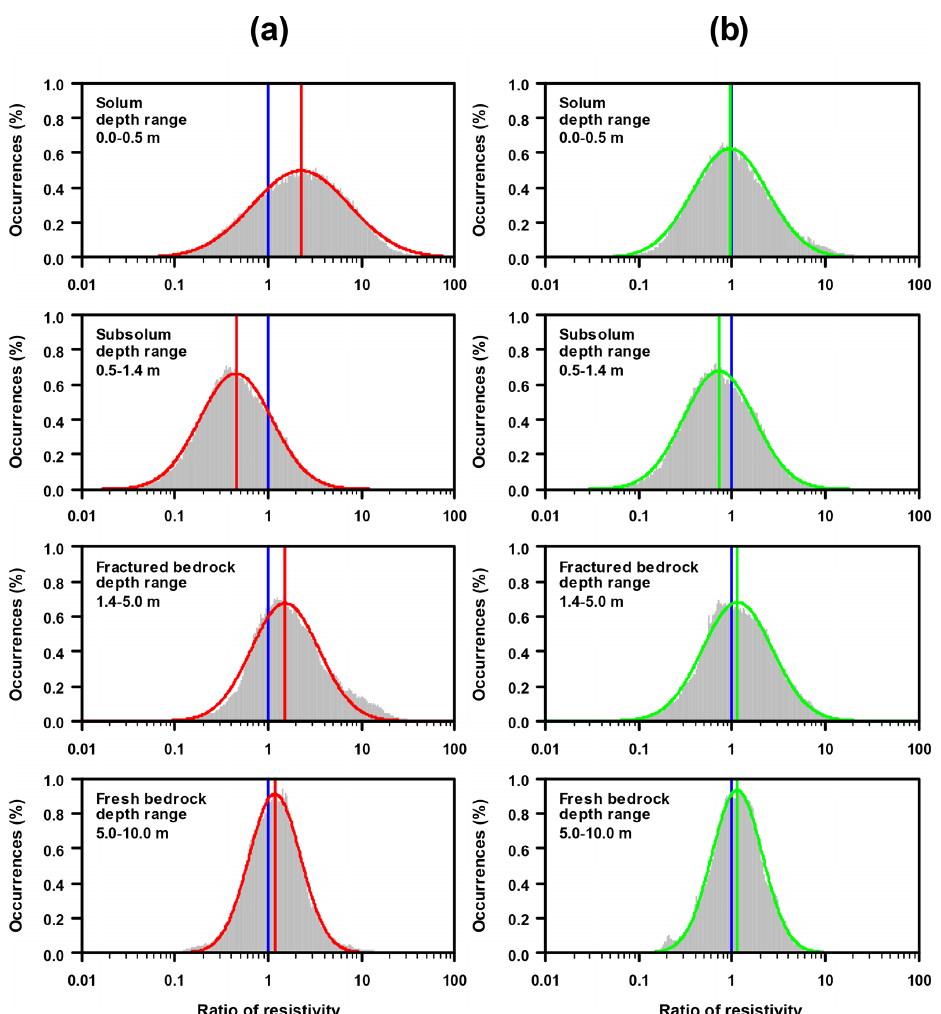
Figure 11. Distribution of the ratios calculated between the inverted resistivities obtained using an ES of 2m without (a) or with the four interpolated levels of surficial apparent resistivity (b) and those obtained using an ES of 0.5m considering the overall 12 plot-scale ERT profiles measured in the Weierbach catchment and discretized by relevant depth horizons. A lognormal distribution, whose centre is indicated by a vertical line, has been fitted for each histogram; the more the distribution is centred and narrowed on the unit ratio (vertical blue lines), the better the adequacy with ERT images using an ES of